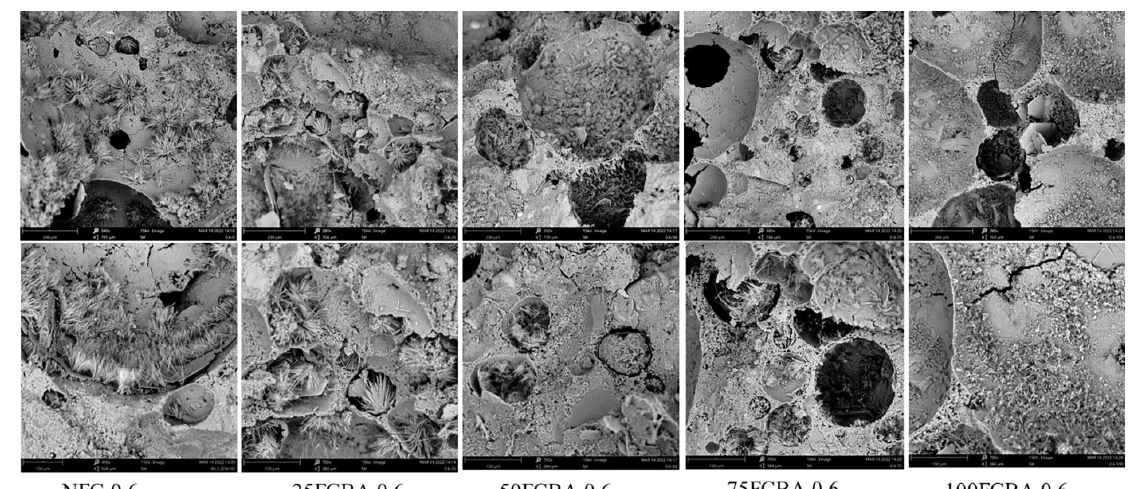
Figure 10. Scanning Electron Micrograph of lightweight foamed concrete